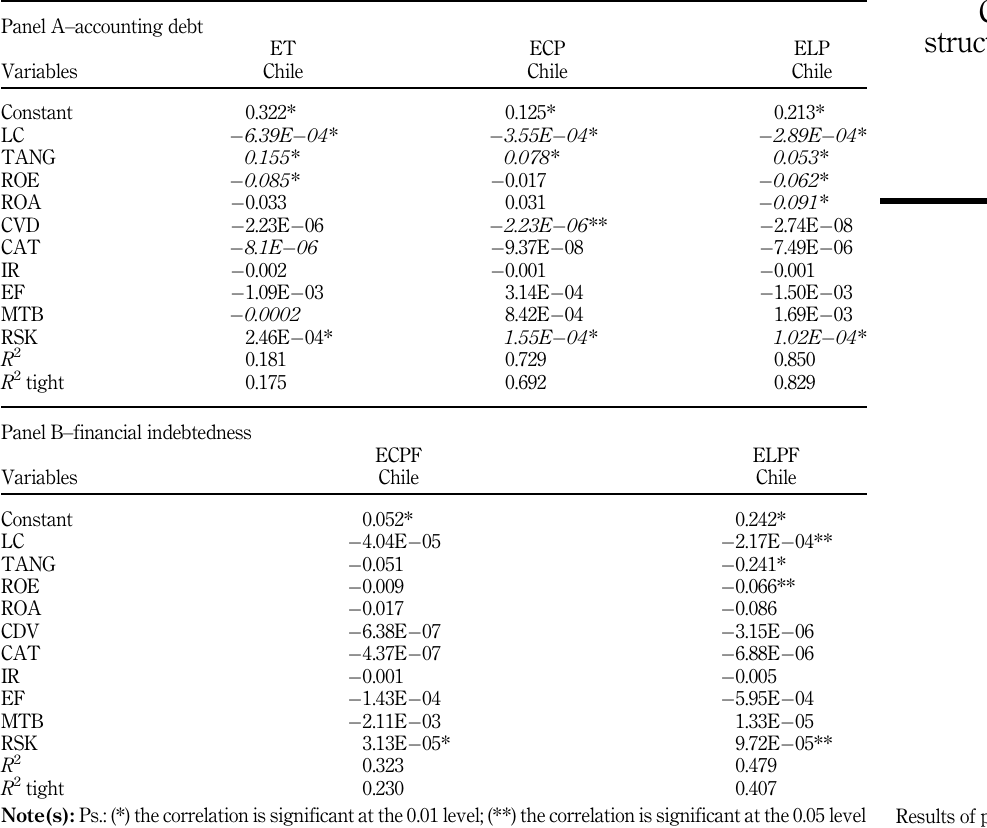
Table 8. Results of panel data